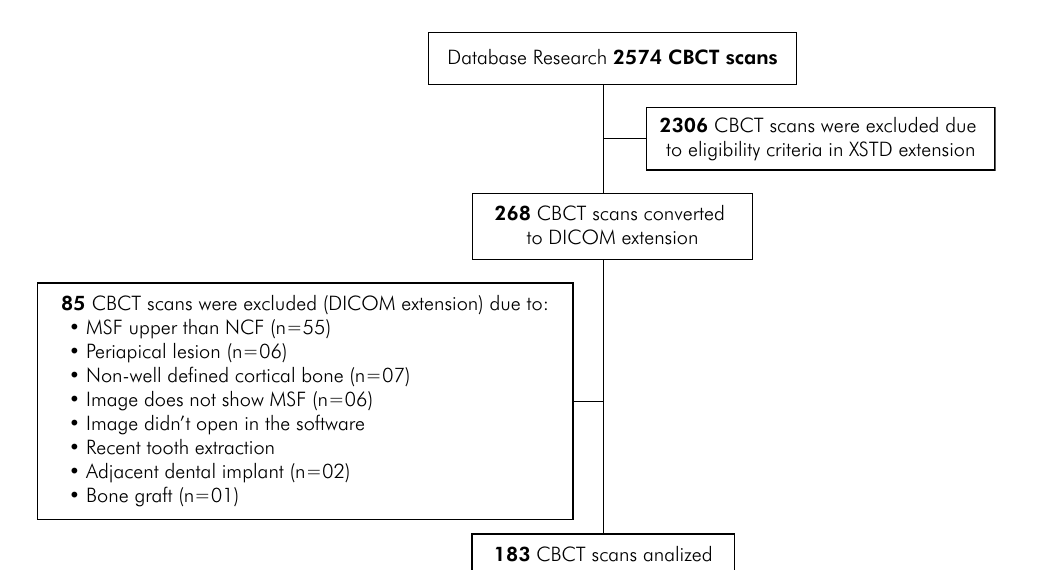
Figure 1. Flowchart: CBCT